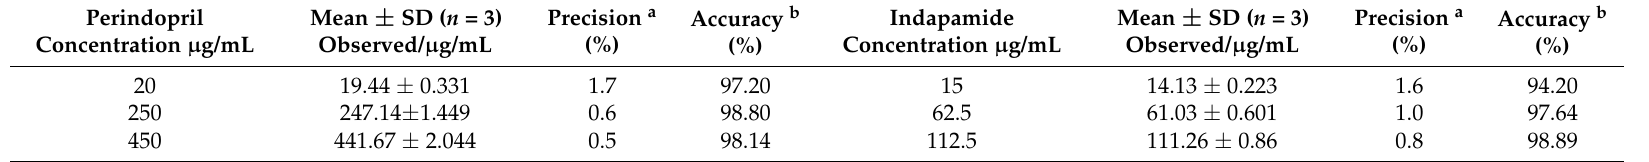
Table 3. Intra-assay precision and accuracy data for Perindopril and Indapamide determination in bulk powder using UPLC-UV. Perindopril Concentration µ g/mL